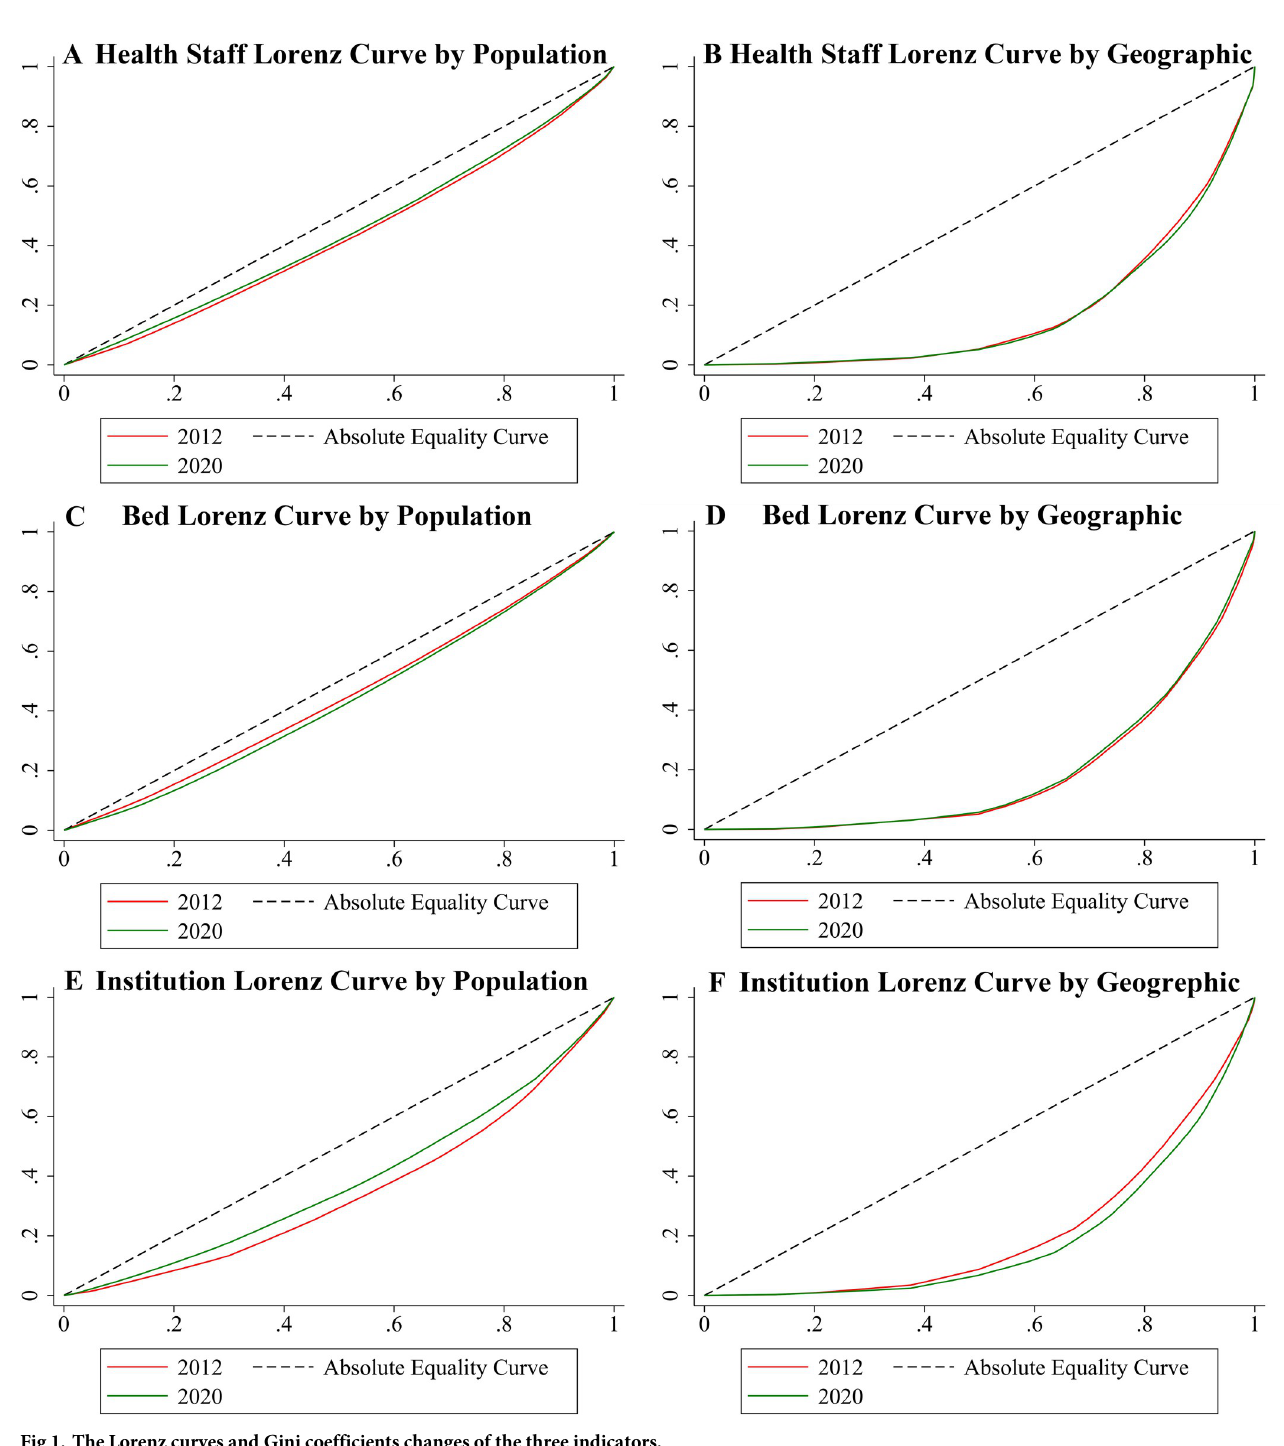
Fig 1. The Lorenz curves and Gini coefficients changes of the three